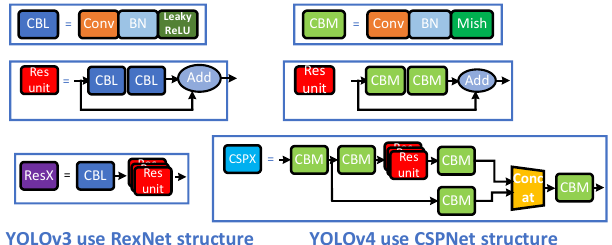
Figure 7 The CSPDarknet53 and Darknet53 module